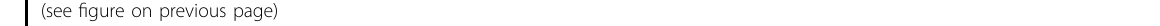
Fig. 1 Structure of the MccE492 and ManYZ complex. a The structure of the MccE492 – ManYZ trimer is shown in both cartoon and surface representations as viewed from the extracellular side of the membrane. MccE492s are colored yellow, except one rainbow-colored, with its N terminus in blue and its C terminus in red, and the posttranslational modi fi cation with a salmonchelin at the C-terminus is schematically shown in red. b The perpendicular view is shown, with the white promotor omitted for clarity. The gray rectangle shows the approximate location of the inner membrane (IM). c Interactions between ManYZ and man-PTS recognition domain of MccE492. Left: surface representation of ManYZ. The man-PTS recognition domain of MccE492 is shown in sticks. Δ 72 – 84 truncation is indicated with a scissor. Right: the same orientation and representation, except the ManYZ in cartoon representation, with key residues emphasized. The hydrogen bonds are indicated with the black dash line. d Bactericidal activity of endogenous full-length and C-terminally truncated or mutated MceA. Serial dilutions of overnight cultures were spotted (5 µl) on LB plates without IPTG (left) or with 0.2% IPTG (right). e Interactions between ManYZ and α -helical domain of MccE492. The α -helical domain of MccE492 is shown in the cartoon, with side chains represented in sticks. Mutated residues in the inhibitory assay of Mcc24 are shown as spheres. Substitutions are indicated in the circles and colored white and blue in the size of the zone of inhibition. f Model of the mechanism of MccE492 antibacterial action. Left: it is proposed that the oligomerization interface of the ManYZ complex may be the λ DNA tunnel for bacteriophage infection. Therefore, MccE492 ’ s association with ManYZ would not affect bacteriophage λ infection. Right: postmodi fi cation by salmonchelin-like molecules at the C terminus of MccE492 is recognized by the outer membrane proteins, FepA, Fiu, and Cir for the transportation from the extracellular medium to the periplasm. The man-PTS recognition domain is then speci fi cally docked into the pocket between Core and Vmotif domain while ManYZ occurs in the occluded state. The man-PTS recognition domain then drives the membrane insertion of the α -helical domain. Pore formation is followed by oligomerization of additional MccE492 ’